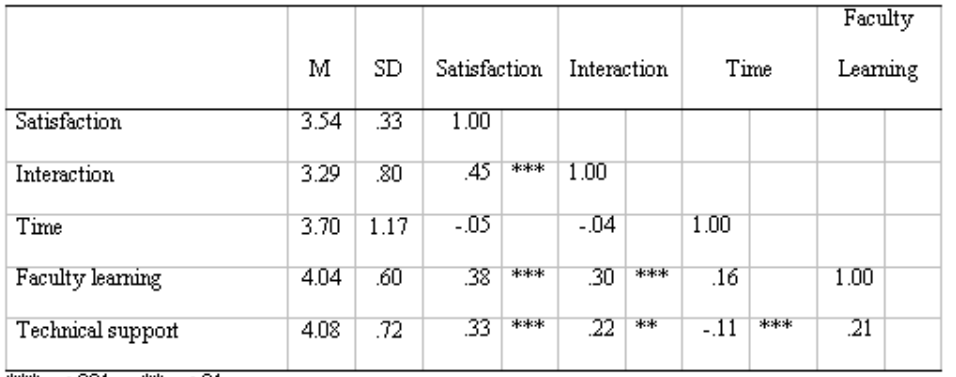
Table 7. Mean, Standard Deviation,